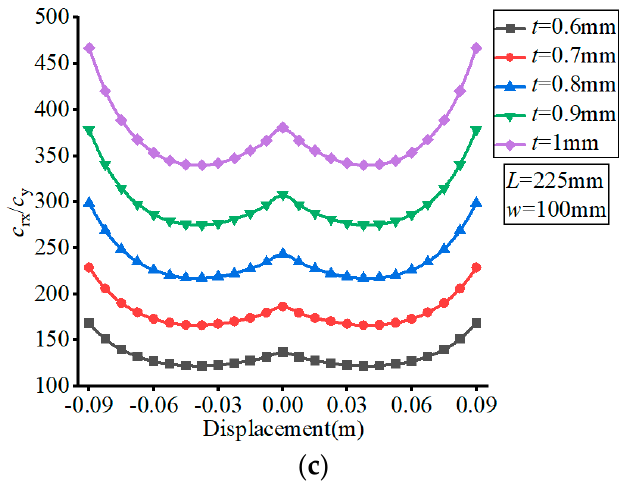
Figure 11. Effect of structural parameters on c rx / c y . ( a ) Effect of L ; ( b ) Effect of w ; ( c ) Effect of t .